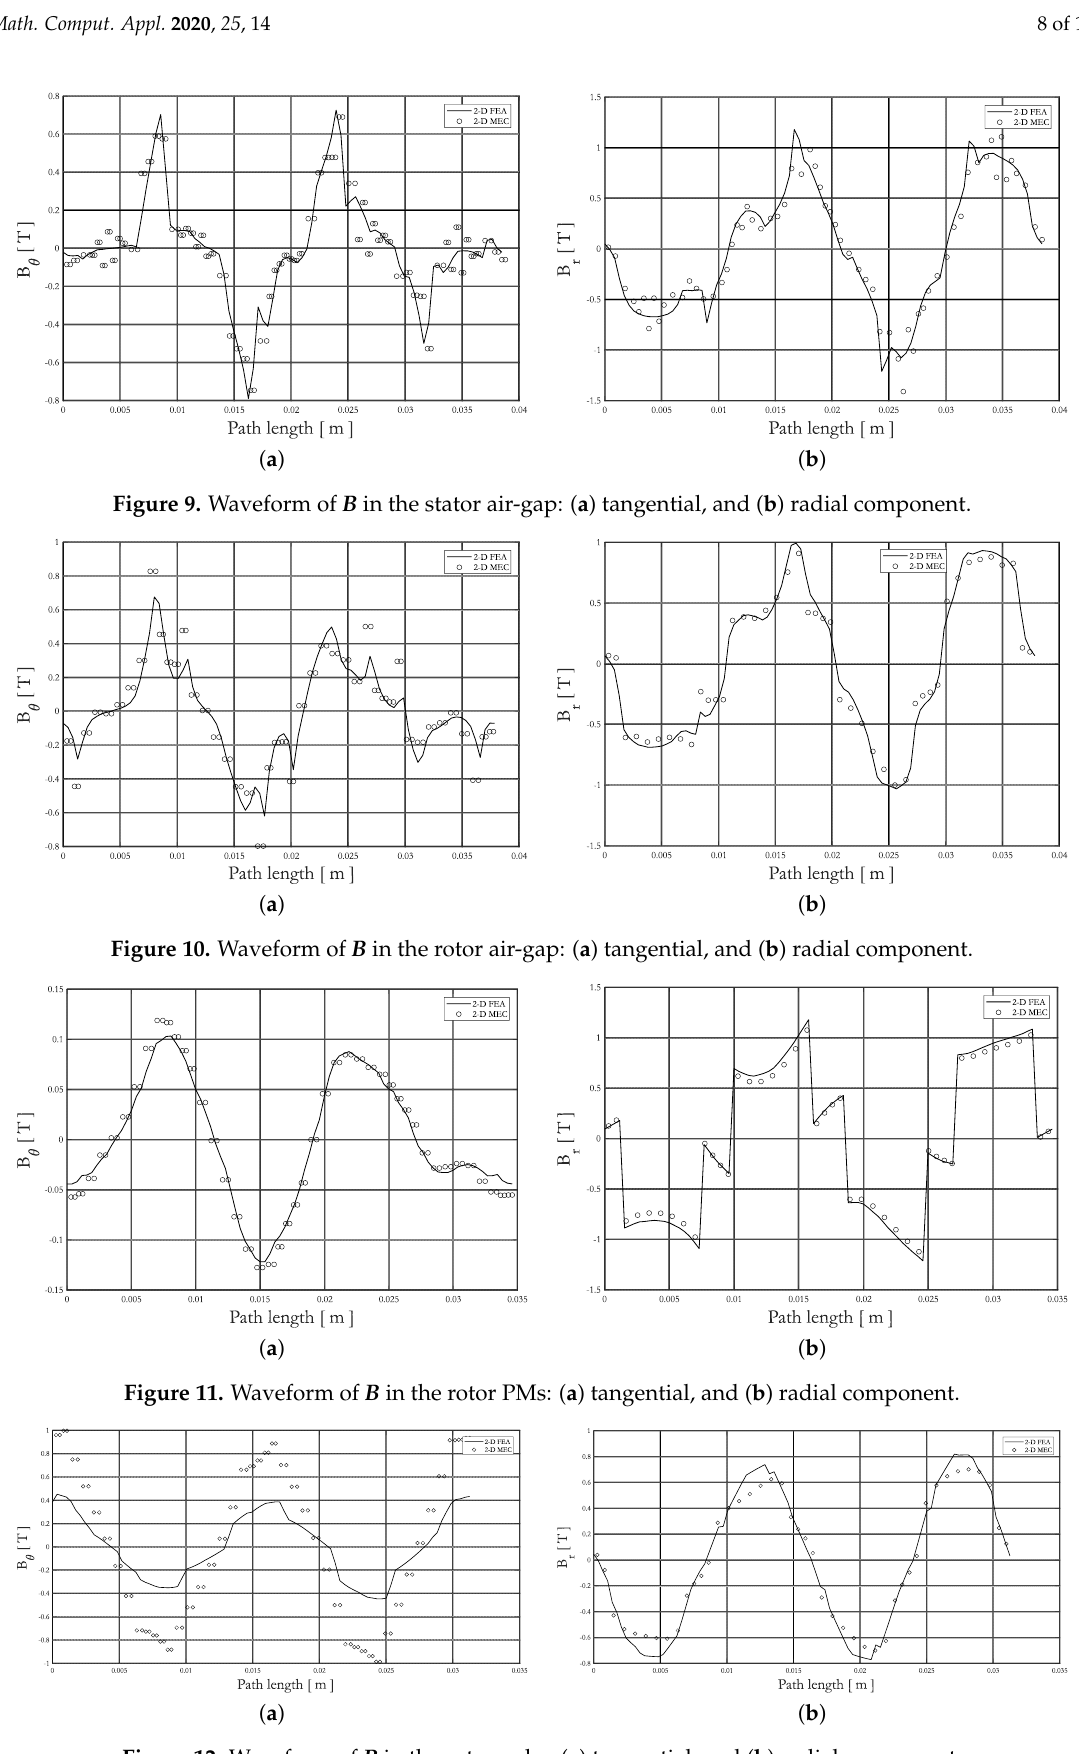
Figure 12. Waveform of B in the rotor yoke: ( a ) tangential, and ( b ) radial